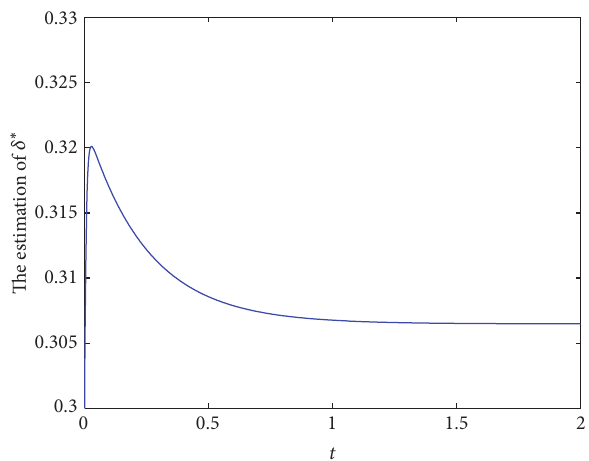
̂𝛿(𝑡) by updated law (13).